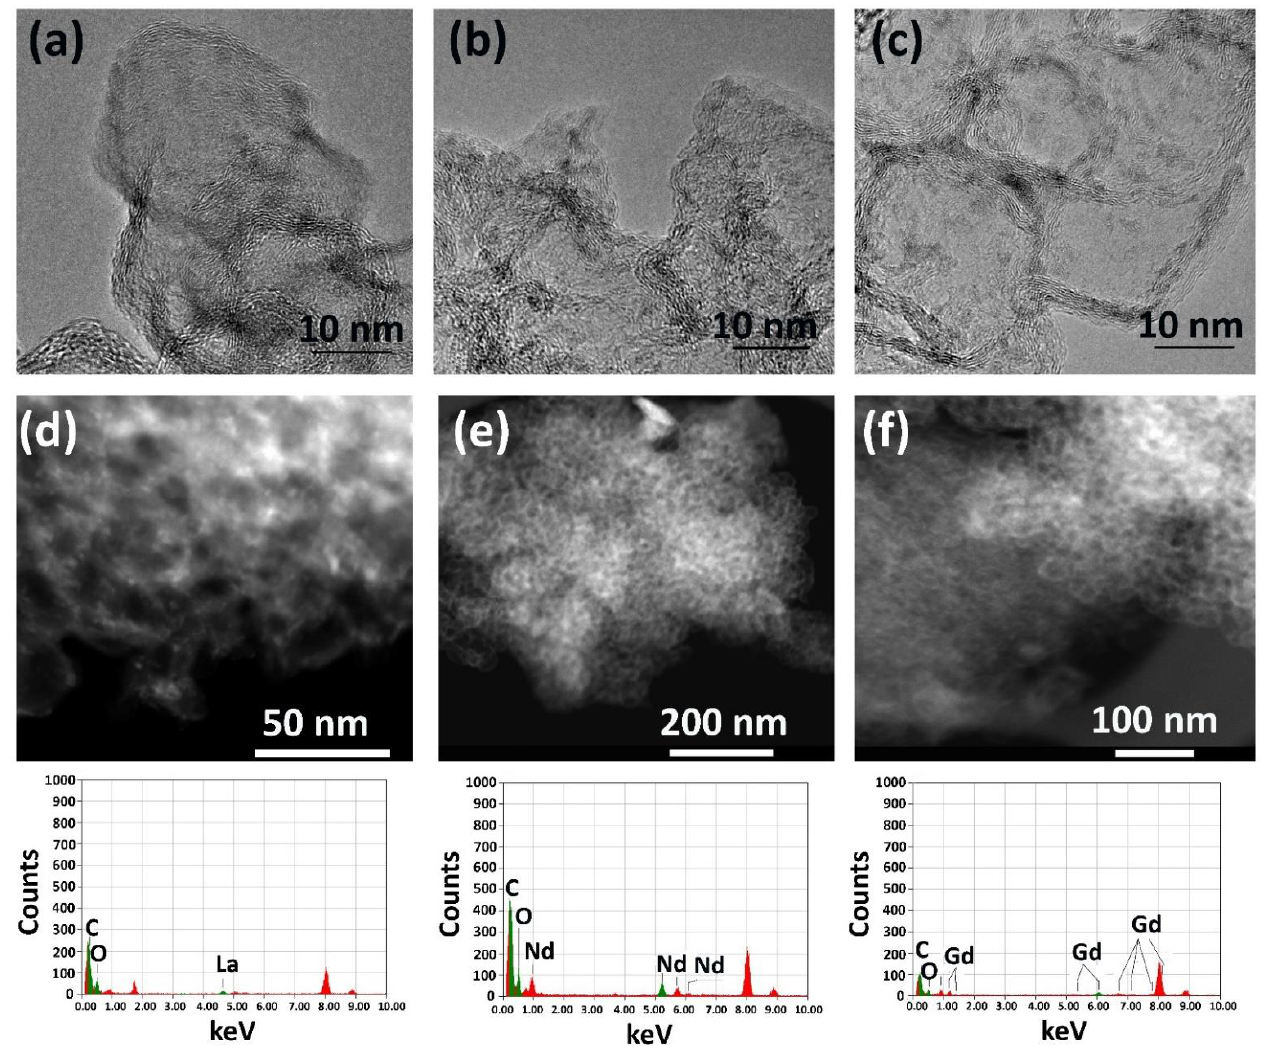
Figure 6. HRTEM (top row), HAADF-STEM (middle row) images and EELS spectra (lower row) of Ln/CNFs_ox particles: La/CNFs_ox ( a , d ), Nd/CNFs_ox ( b , e ), and Gd/CNFs_ox ( c , f ).